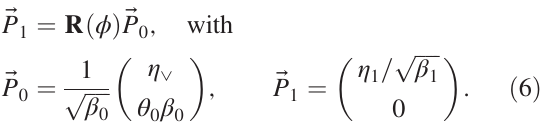
FIG. 1. Course of dispersion and equivalent thin-dipole dispersion for half-cells with one bend. The half-cell ends are denoted by blue and orange lines. In the bend-free region (shaded area), β ð s Þ and η ð s Þ are